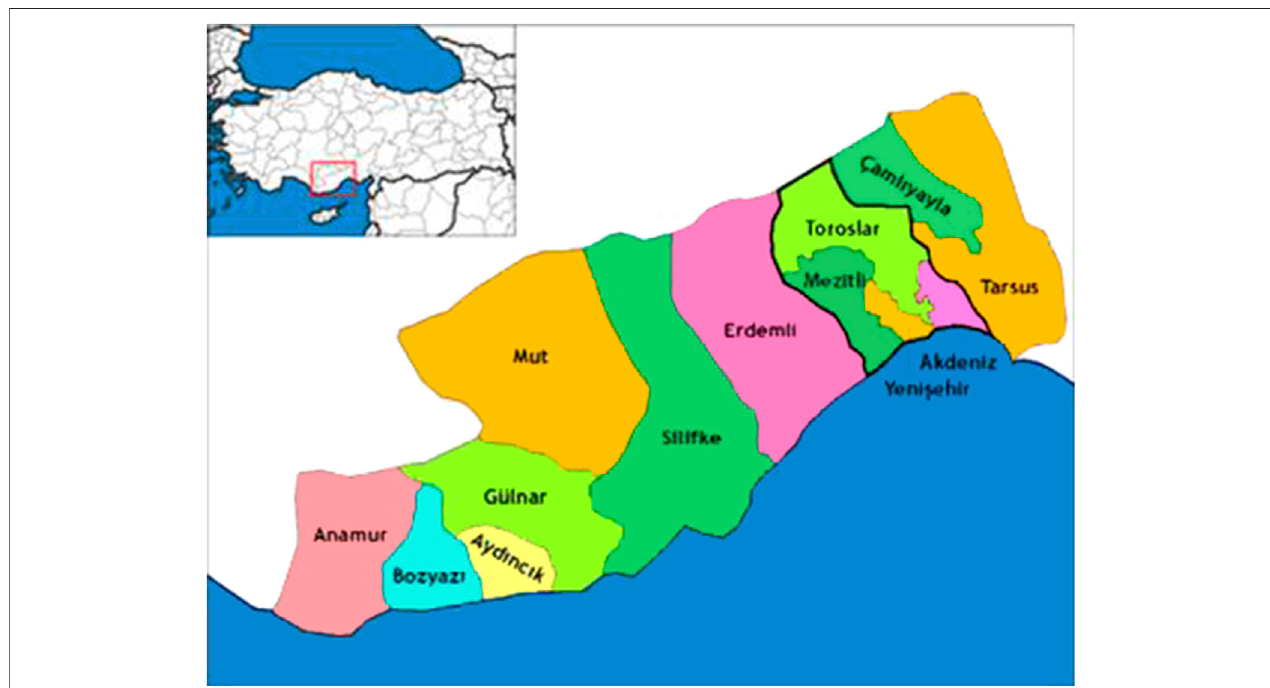
FIGURE 1 | Map of mersin